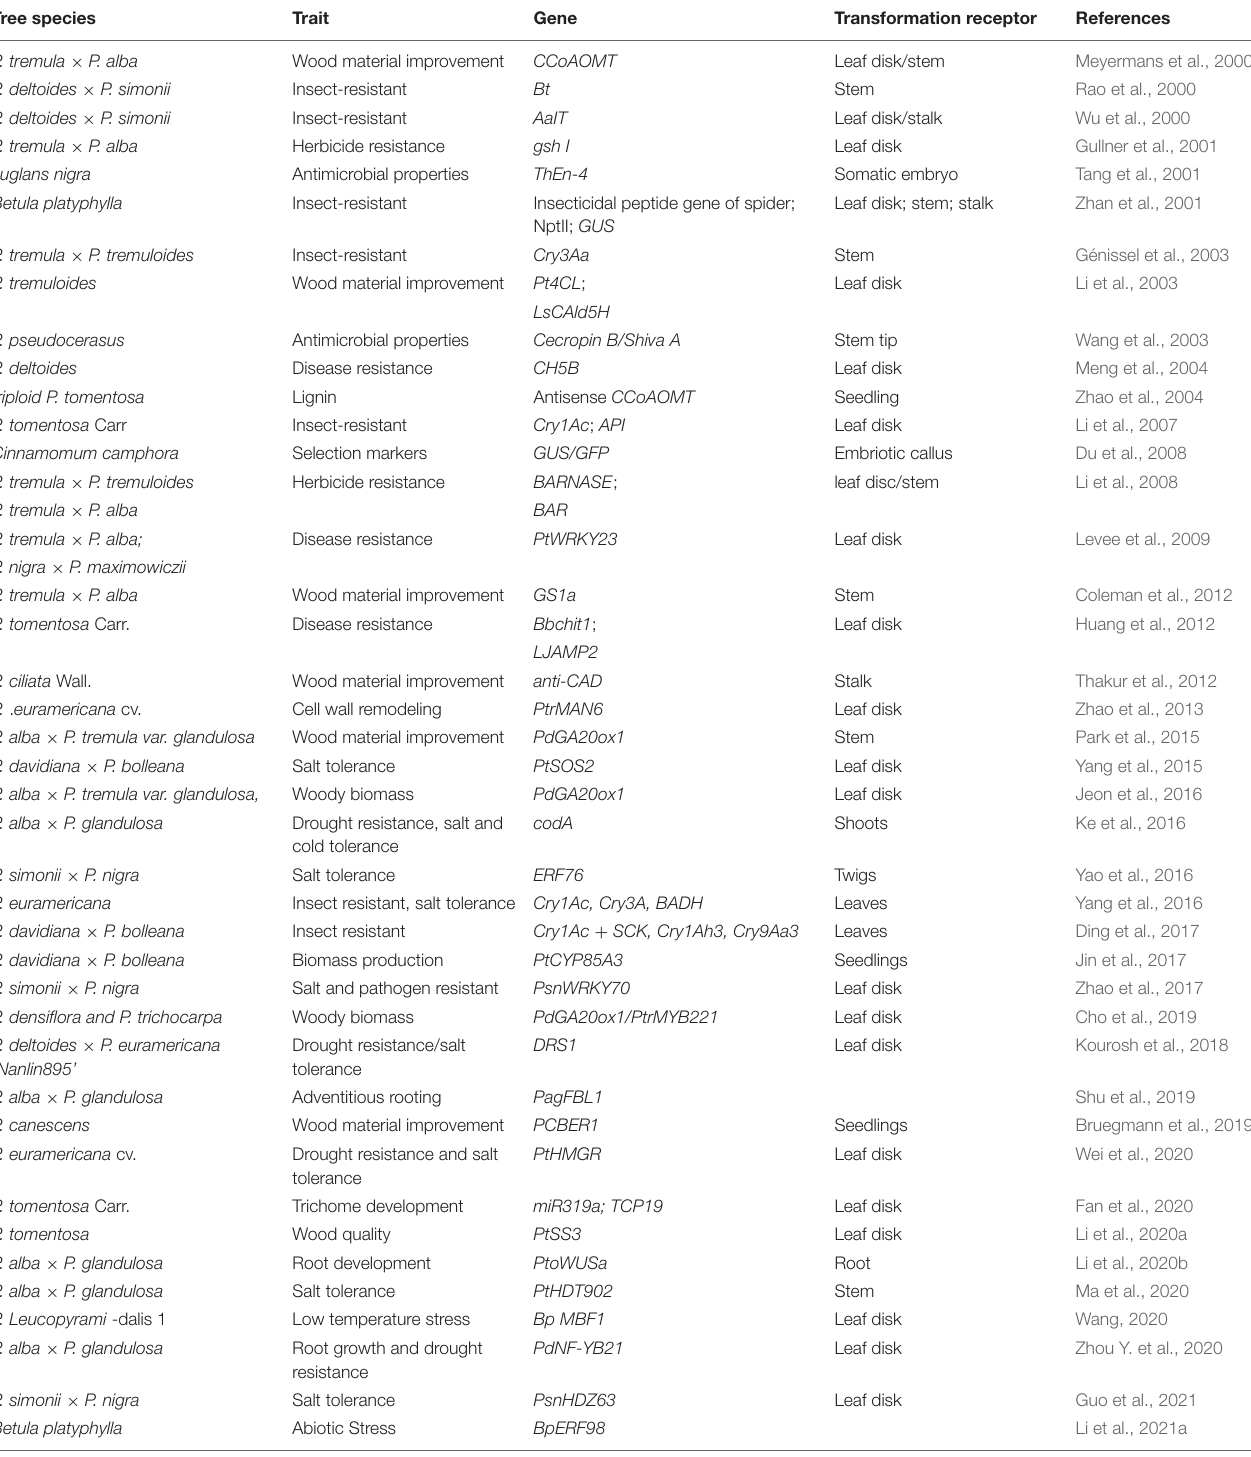
TABLE 1 | Transgenic plants successfully obtained by Agrobacterium tumefaciens transformation. Tree